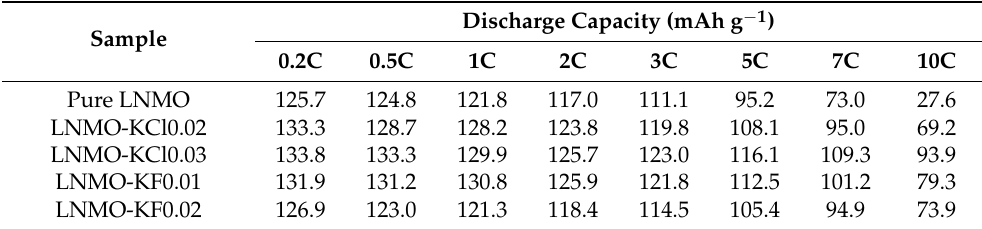
Table 4. Discharge capacity at different C-rates for all samples between 3.5 and 5 V.